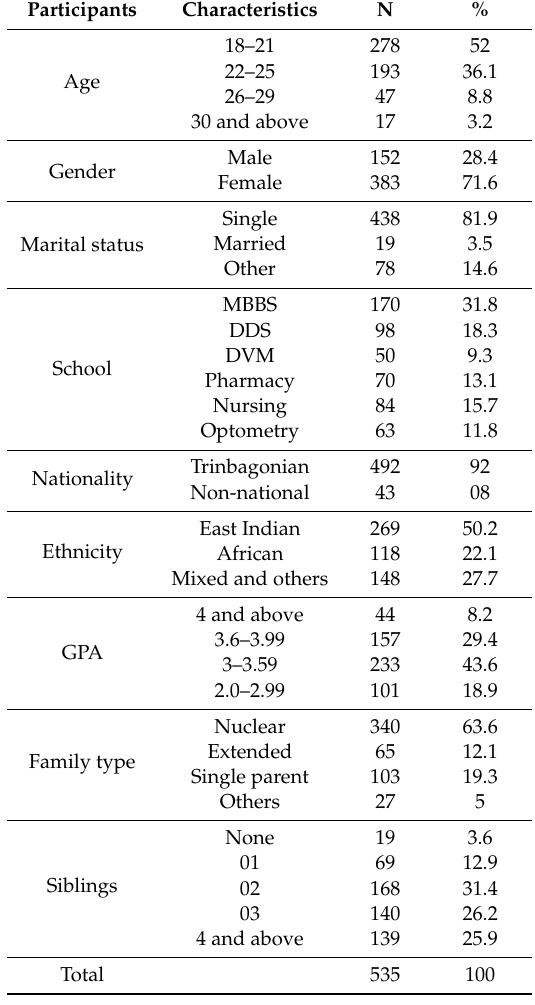
Table 1. Sociodemographic characteristics of the